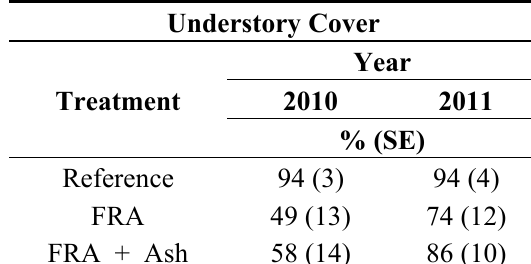
Table 4. Mean percent understory cover and standard error by treatment after the first (2010) and second (2011) growing season, with standard error of the mean in parentheses. Reference is the standard mine reclamation technique, FRA is the modified Forestry Reclamation Approach, and FRA + Ash is the modified Forestry Reclamation Approach with an addition of bottom ash from the on-site coal burning power plant (SE: standard